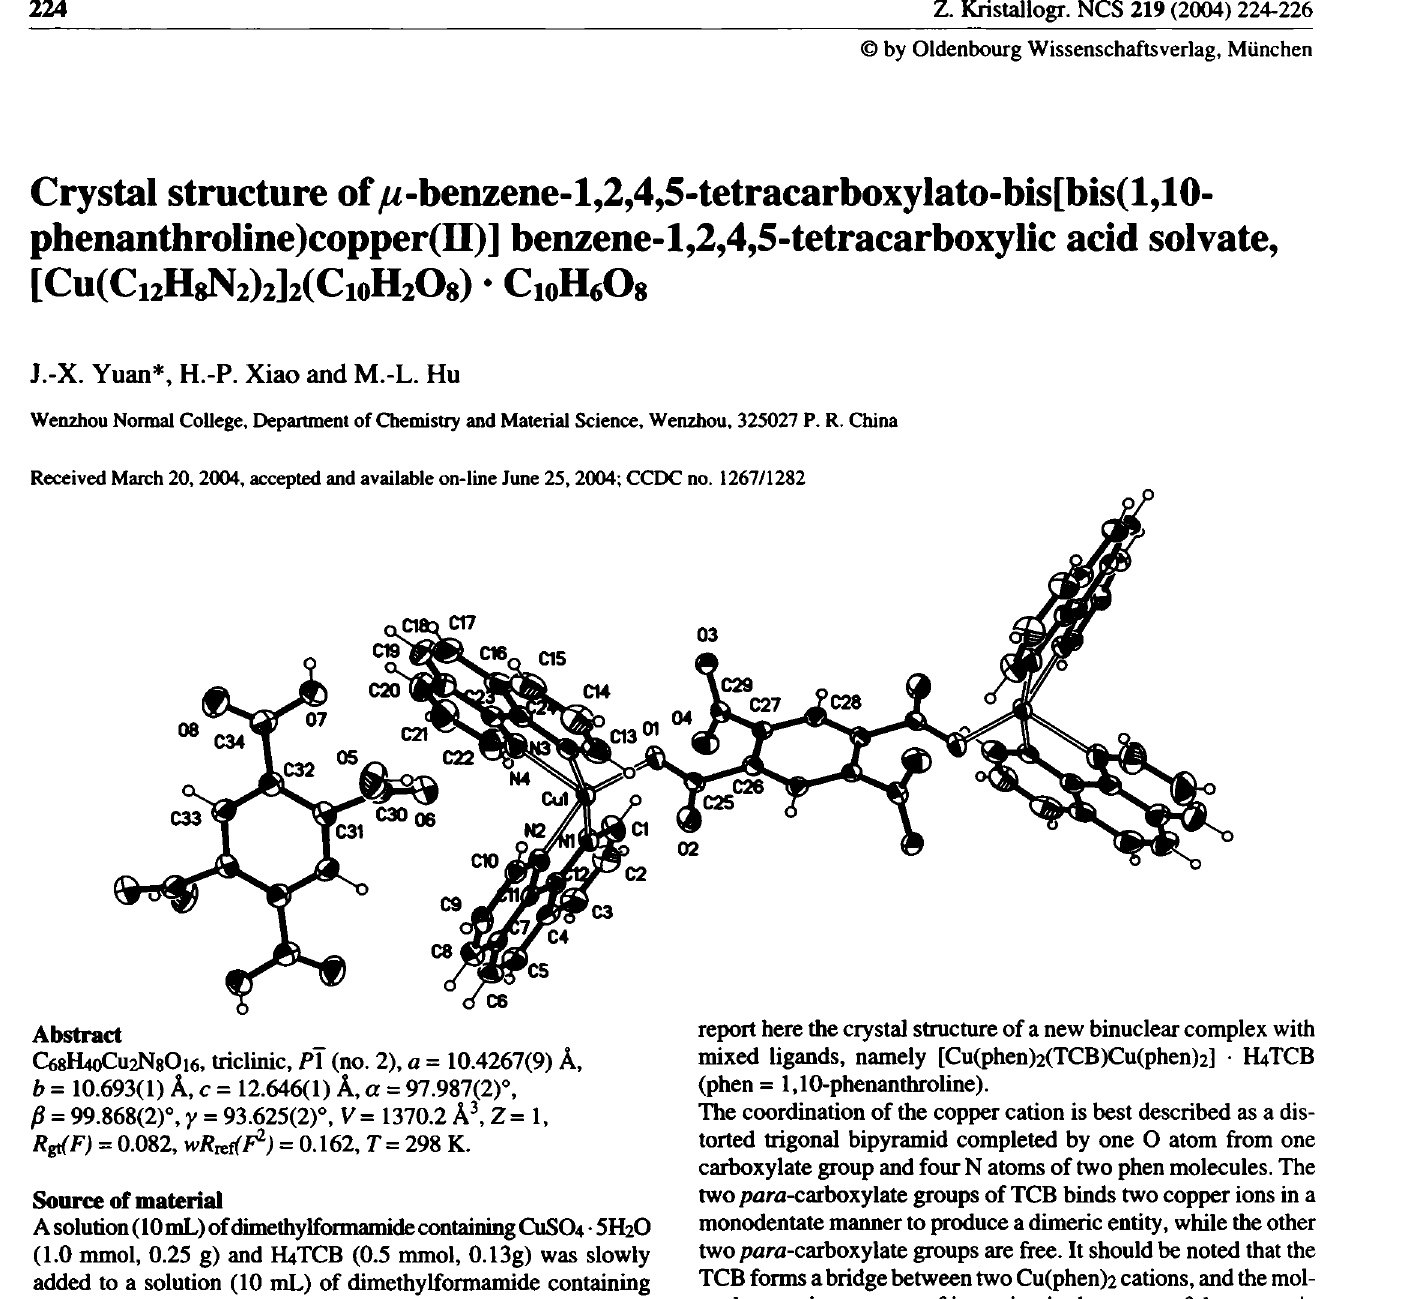
Table 1. Data collection and